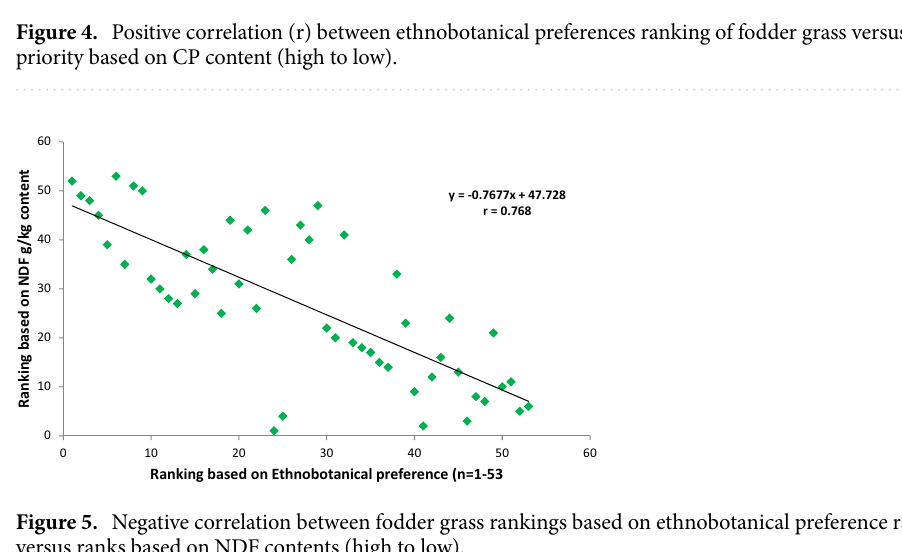
Figure 5. Negative correlation between fodder grass rankings based on ethnobotanical preference ranking versus ranks based on NDF contents (high to low).